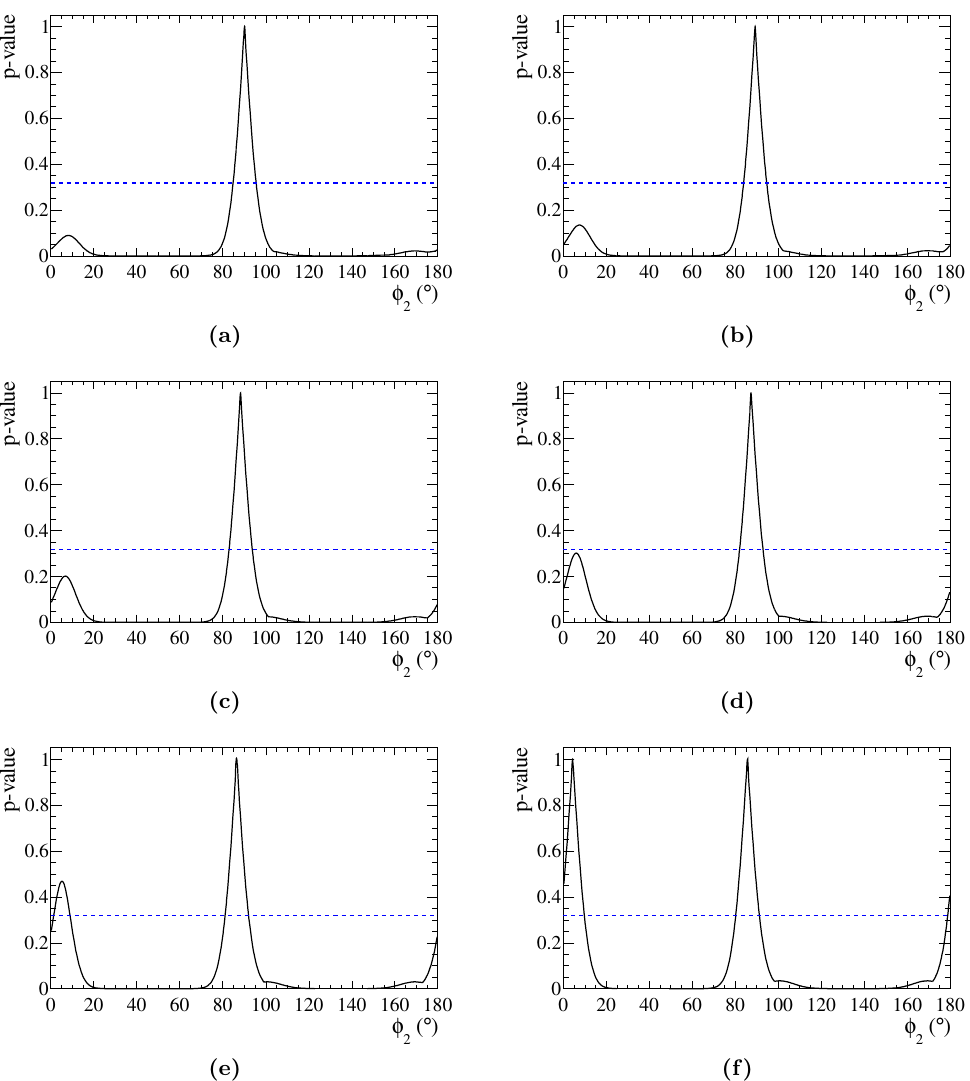
Figure 4 . p -value scans of (cid:30) 2 where the central value of (cid:30) 00 is set to (a) (cid:30) 00 2 (c) (cid:30) 00 = 60 (cid:14) (d) (cid:30) 00 = 55 (cid:14) (e) (cid:30) 00 = 50 (cid:14) (f) (cid:30) 00 = 45 (cid:14) . The horizontal dashed line indicates the 2 2 2 2 1 (cid:27)